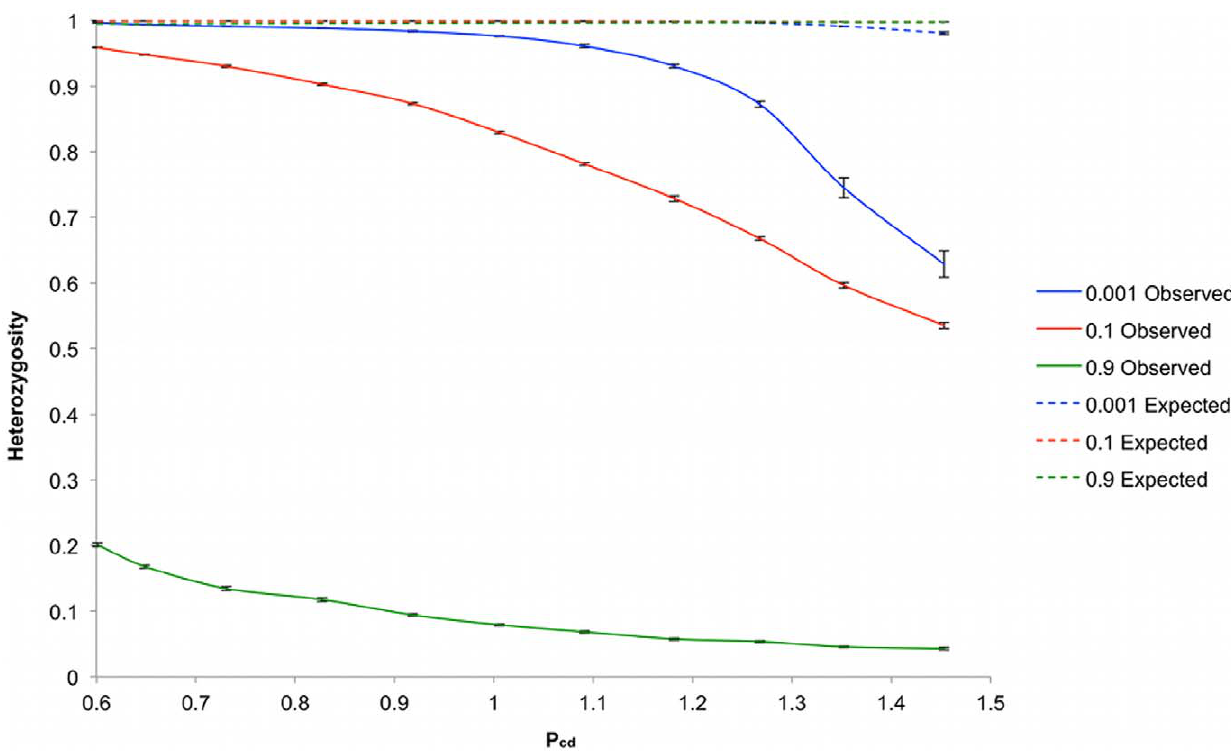
Figure 3. Heterozygosity as a function of matrix sizes. Heterozygosity was plotted at S u =0.001 (blue), S u =0.1 (red) and S u =0.9 (green). H o is plotted with the solid line and H e using a dashed line. Simulations were repeated ten times for each value of S u , with error bars representing the standard error.